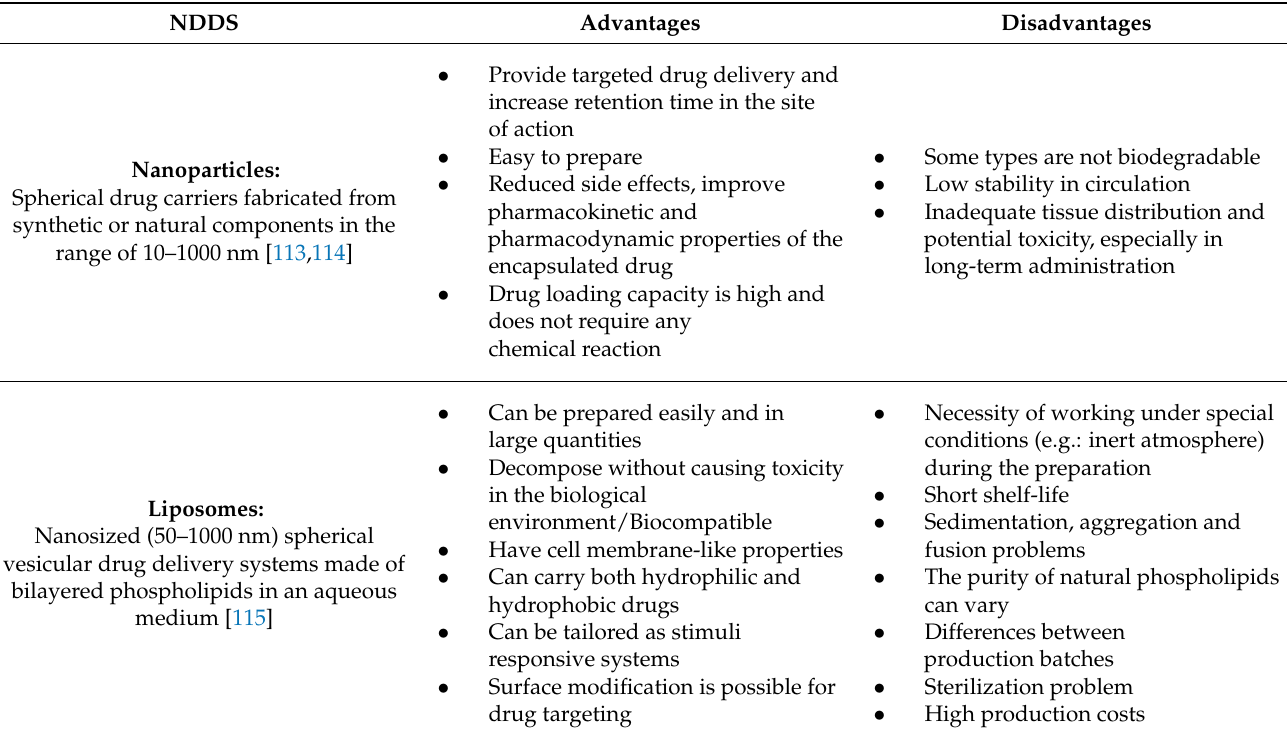
Table 6. Advantages and disadvantages of common NDDS used to deliver antioxidants.